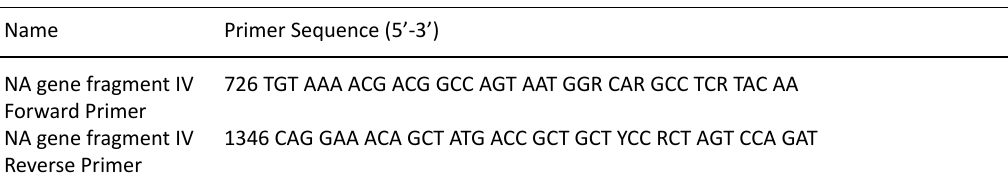
Table 2. Sequence of Primers used for one step RT PCR 12